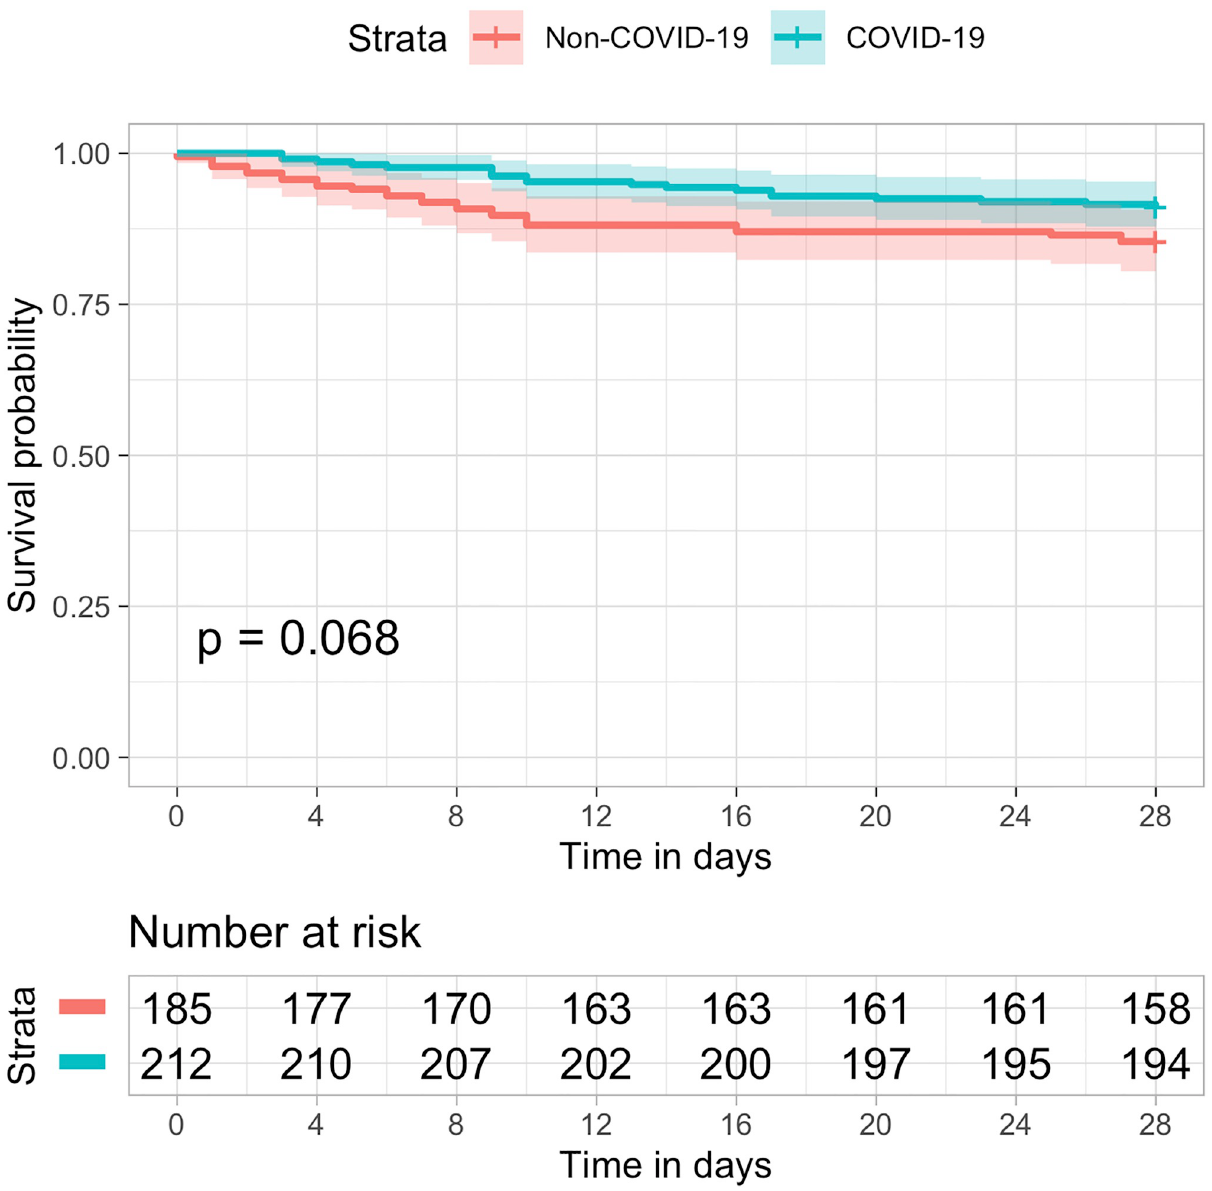
Fig 2. Kaplan–Meier estimates of all-cause survival rate up to 28 days. Symbols (tick marks) indicate censored data. Overall survival was not significant different in COVID-19 (blue) as compared to non-COVID patients (orange) in the previous year (logrank p =